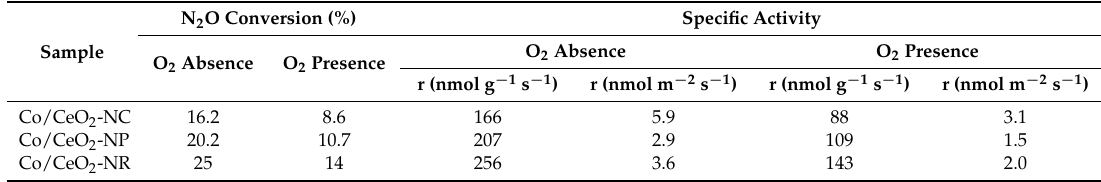
Table 4. The N 2 O conversion and specific activity of Co/CeO 2 samples at 420 ◦ C: The